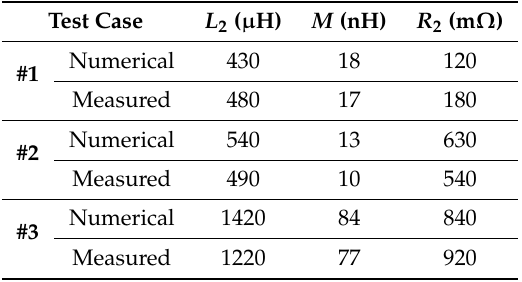
Table 3. Calculated and measured secondary circuit parameters.